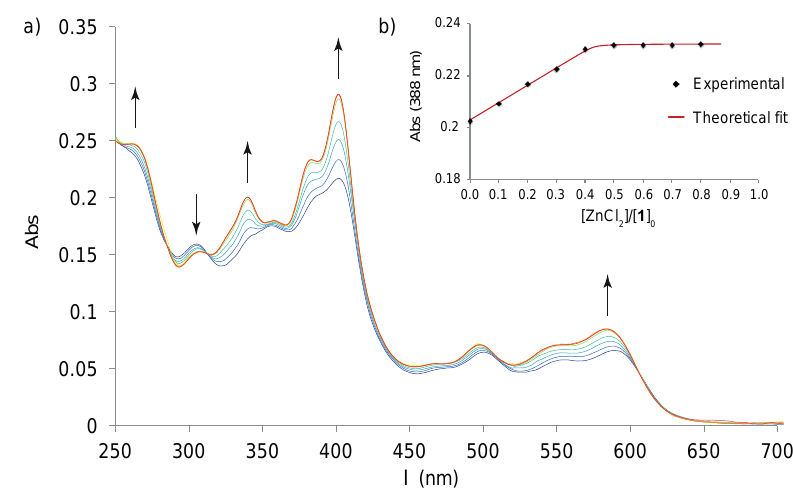
Figure 4. a ) UV-Vis titration of 1 (5.0 × 10 −6 mol·L −1 ) by ZnCl 2 in CHCl 3 and b ) Absorption at 388 nm Figure 4. ( a ) UV-Vis titration of 1 (5.0 × 10 − 6 mol · L − 1 ) by ZnCl 2 in CHCl 3 and ( b ) Absorption at Figure 4. ( a ) UV-Vis titration of 1 (5.0 × 10 − 6 mol·L − 1 ) by ZnCl 2 in CHCl 3 and ( b ) Absorption at 388 nm and fitting with a 2:1 binding model. 388 nm and fitting with a 2:1 binding model. and fitting with a 2:1 binding model.